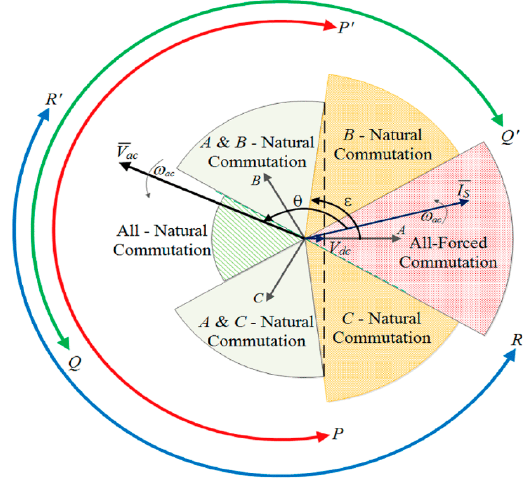
Figure 19. Commutation diagram during ac-to-dc source transition [10].